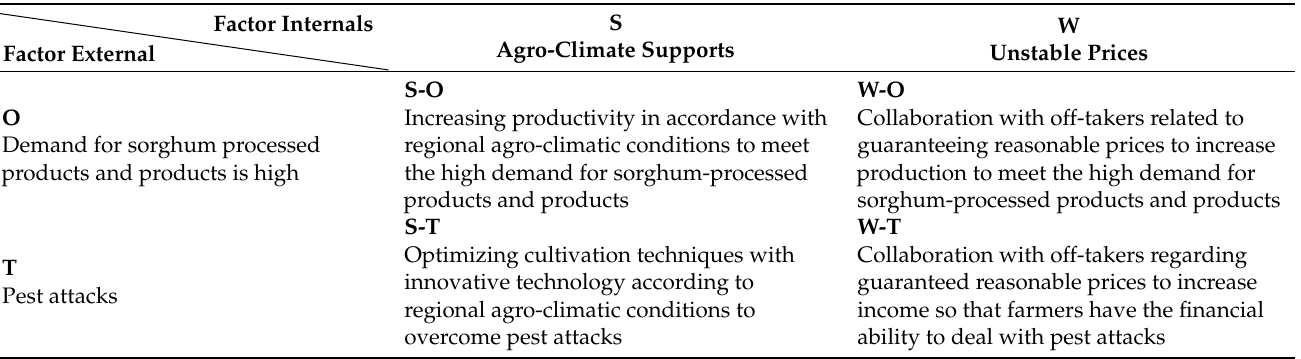
Table 7. SWOT strategy formulation for sorghum development in Wonogiri Central Java, 2022.